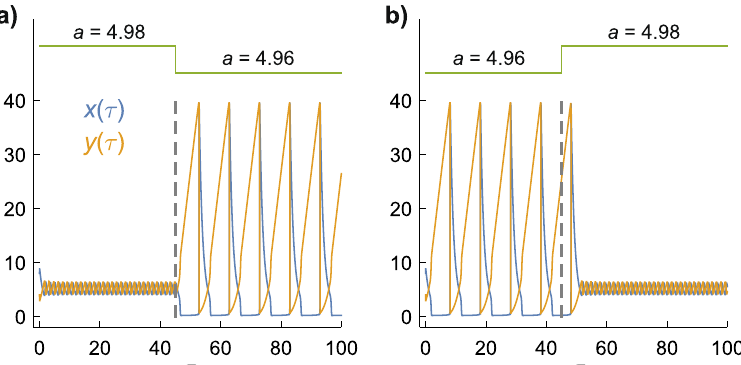
Figure 3. Time-dependence of the concentrations x (τ) and y (τ) when small, sudden changes are made in the value of a . b = 26 for both panels. ( a ) a = 4.98 → a = 4.96. ( b ) a = 4.96 → a = 4.98. The initial conditions are x (0) = 8, y (0) = 4. The green lines at the top indicate the changes in a . The vertical dashed line at τ = 45 marks the time at which a is changed.